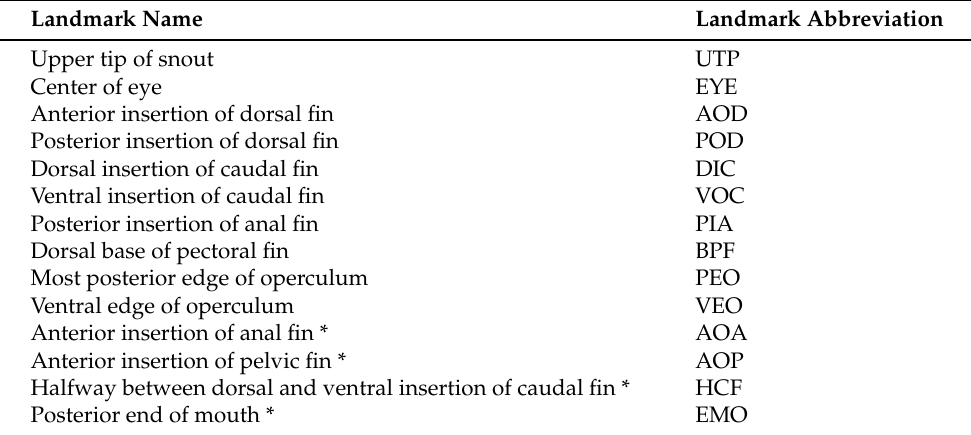
Figure 4. The used landmarks for GPA coordinate scaling. The green landmarks were not used for the images obtained in Uganda. Table 2. Description of the landmarks used in this study. The asterix (*) indicates landmarks not used on Ugandan